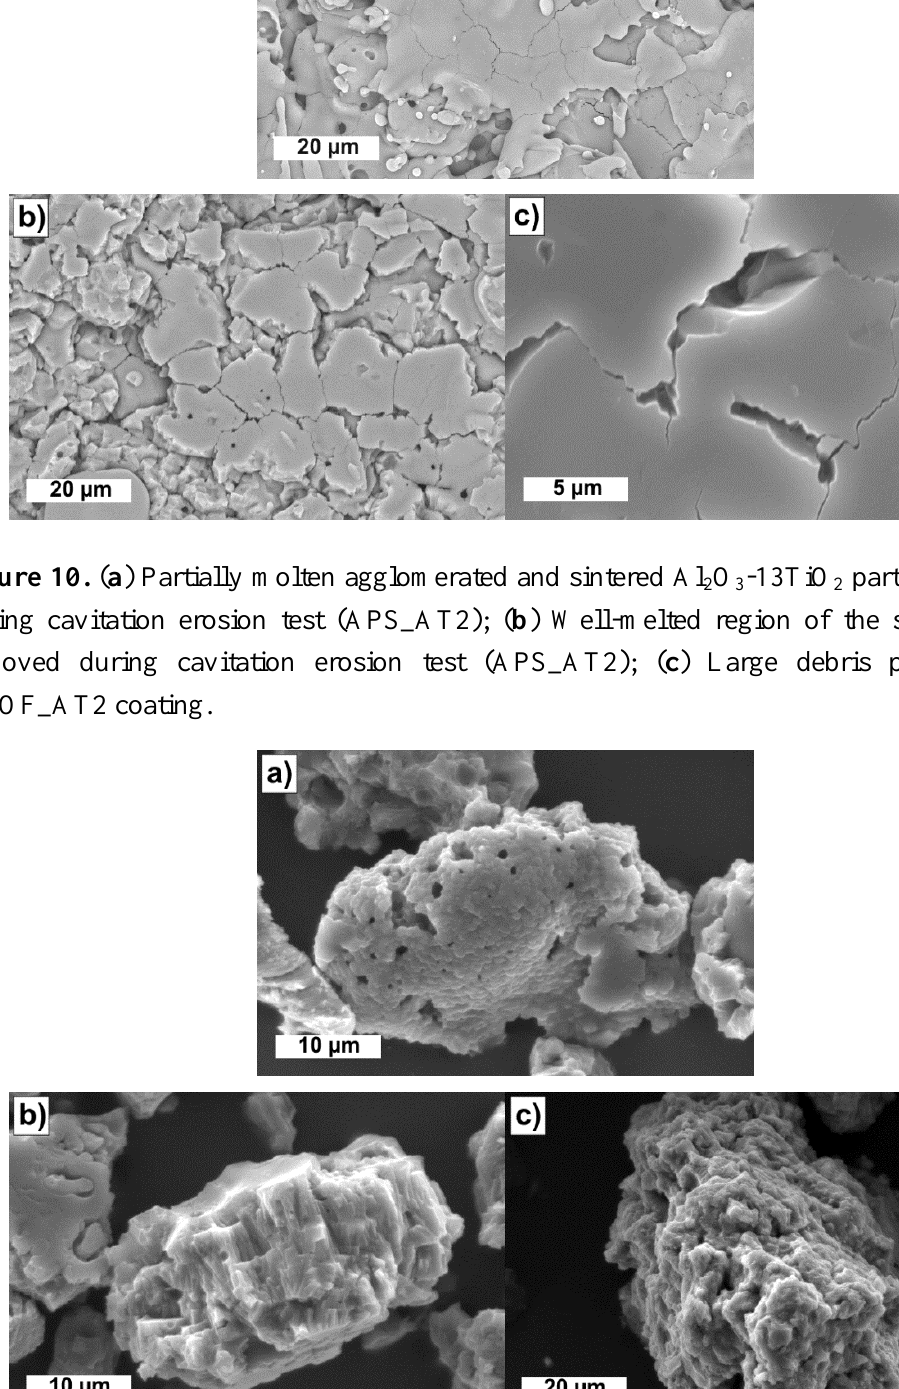
Figure 9. ( a ) Lamella on as-sprayed APS_A coating; ( b ) Lamella after cavitation erosion (APS_A); ( c ) Microcracks being worked at by cavitation erosion (APS_A).